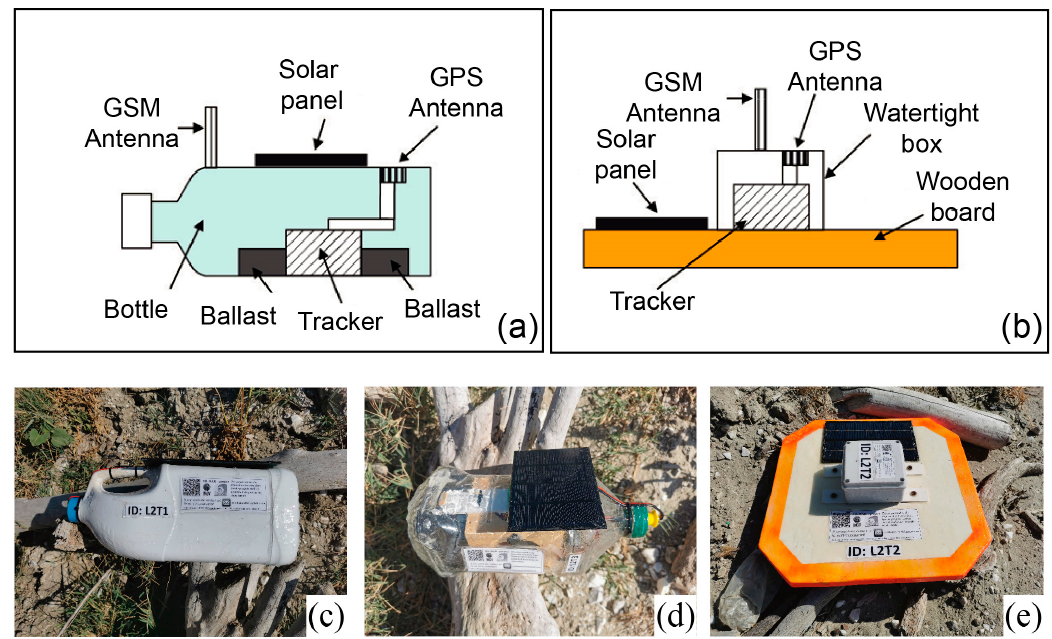
Figure 5. Scheme of the two types of MLT (top panels) and pictures of some of the realized MLTs Figure 5. In top panels, the scheme of the two types of MLT (table-shaped type in panel ( a ) and (bottom panels): in panel ( a , b ) the table-shaped type, in panels ( c – e ) two different bottle-shaped bottle-shaped type in panel ( b )) and in bottom panels pictures of some of the realized MLTs (two types of different shape and volume. different bottle-shaped types, of different shape and volume, in panels ( c , d ) and the table-shaped type in panel ( e